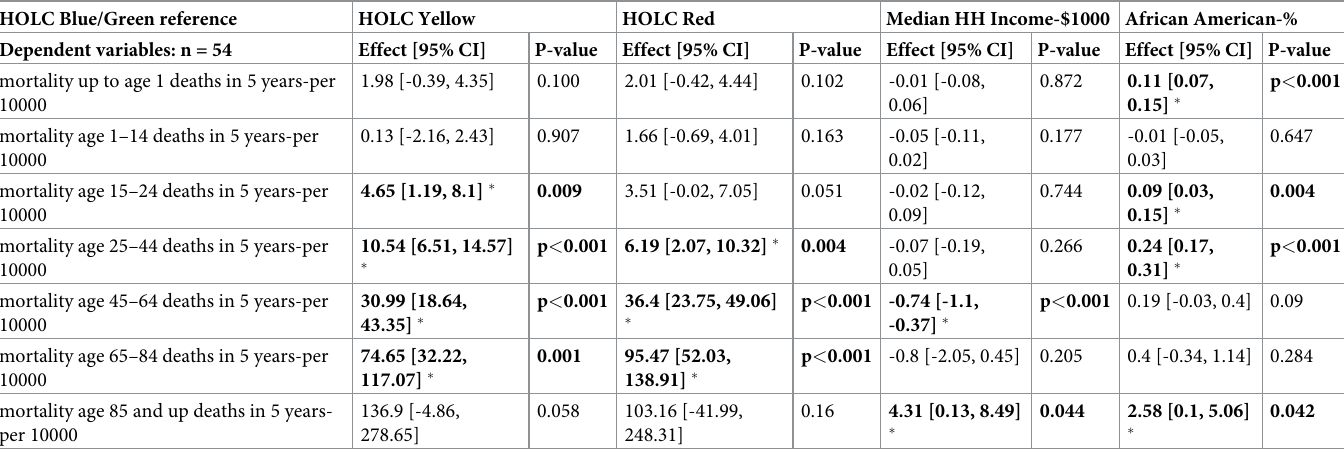
Table 3. Multivariable ordinary least squares analysis of Baltimore HOLC and 2013 mortality by age bins. HOLC Blue/Green